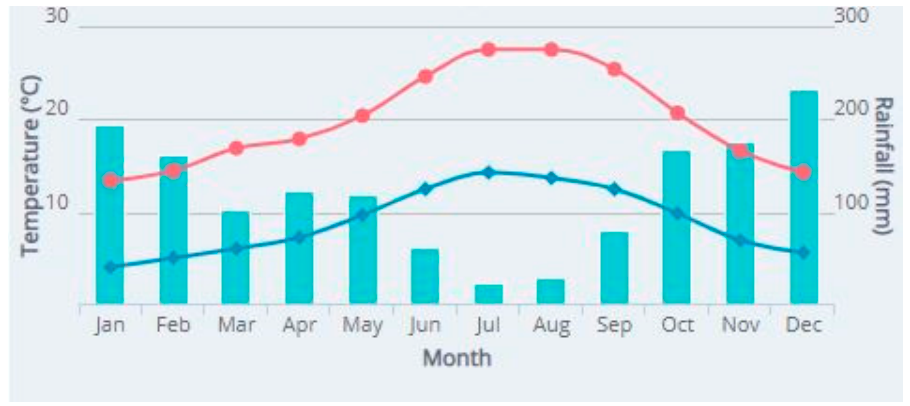
Figure 3. Climatological information based on monthly averages for the 30-year period 1971–2000 of the Territorial Context 2 [38]. Table 2. Description of Territorial Context 2. Figure 4. Climatological information based on monthly averages for the 30-year period 1971-2000 of the Territorial Context 3 [39]. Table 3. Description of Territorial Context 3.